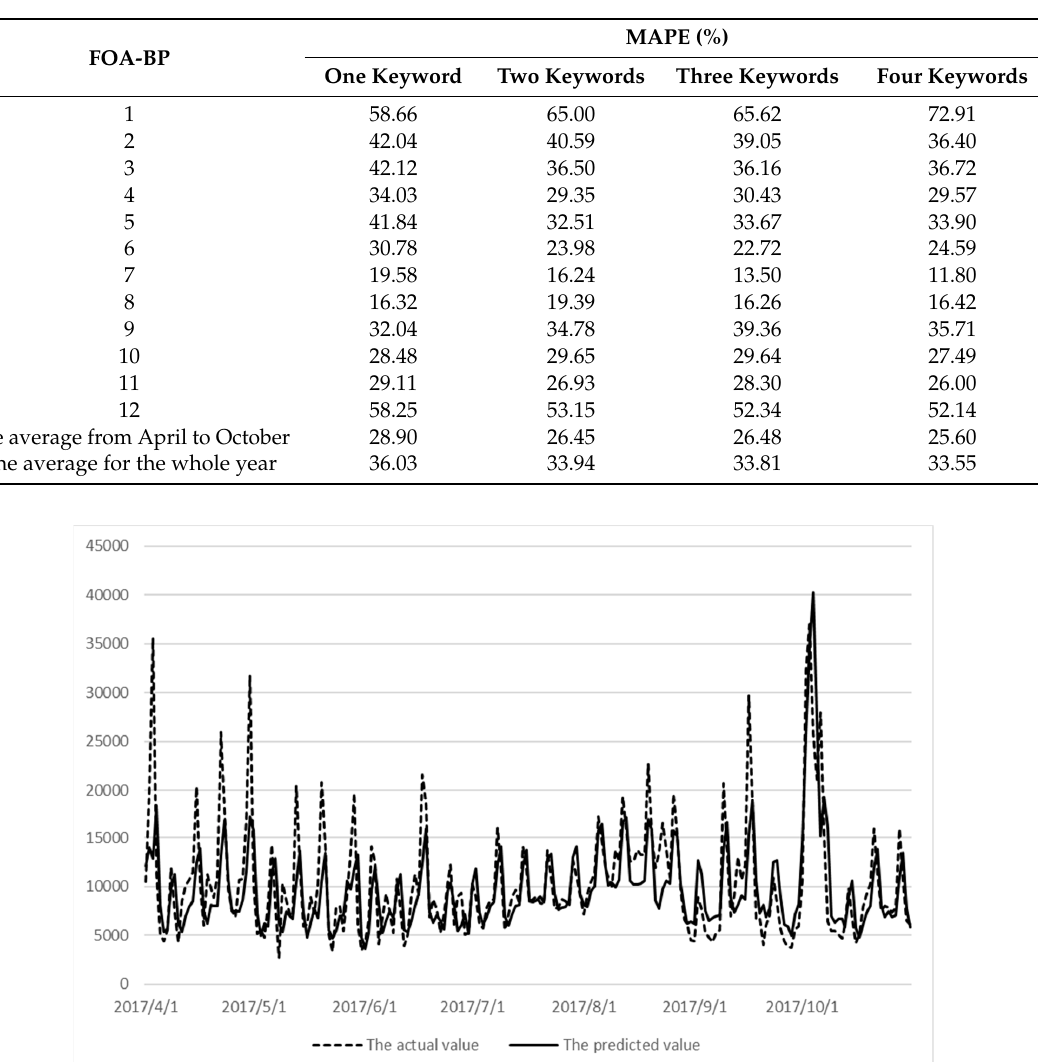
Figure 4. The actual and predicted value.